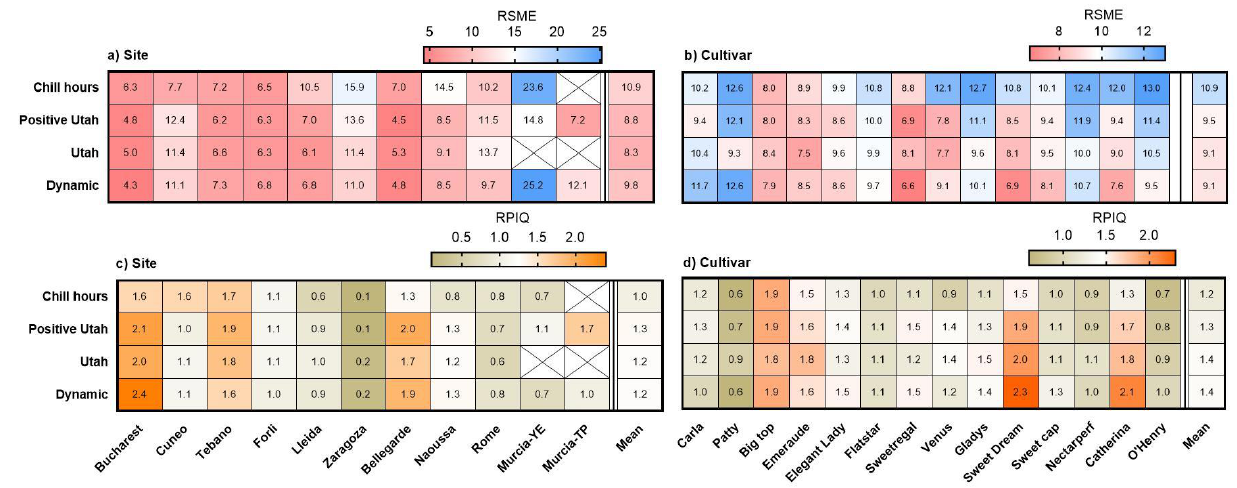
Figure 6. ( a , b ) Root mean square error (RMSE), and ( c , d ) ratio of performance to interquartile distance (RPIQ), for the observed versus estimated full bloom dates for ( b , d ) 14 peach and nectarine cultivars, and ( a , c ) at 11 European sites, calculated using four models. Sites are presented from those having the highest to the lowest chill accumulation, and cultivars from having the lowest to the highest chill requirements. Chill requirements are estimated using the Dynamic Model.